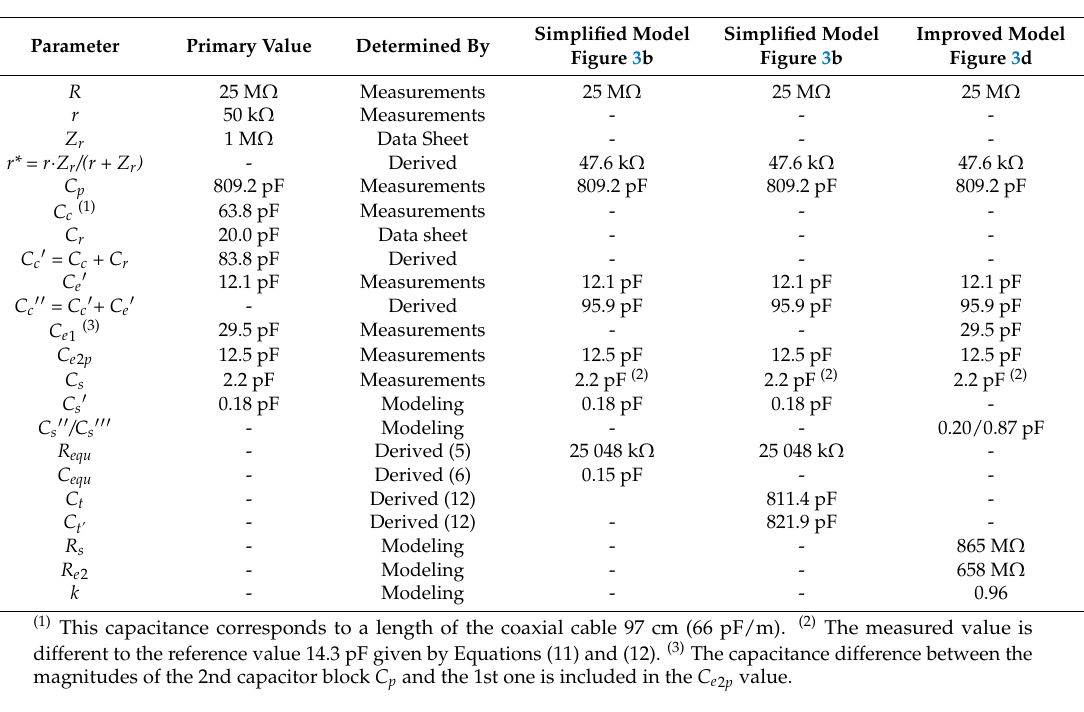
Table 1. Electrical parameters of the built high-voltage (HV) sensor.